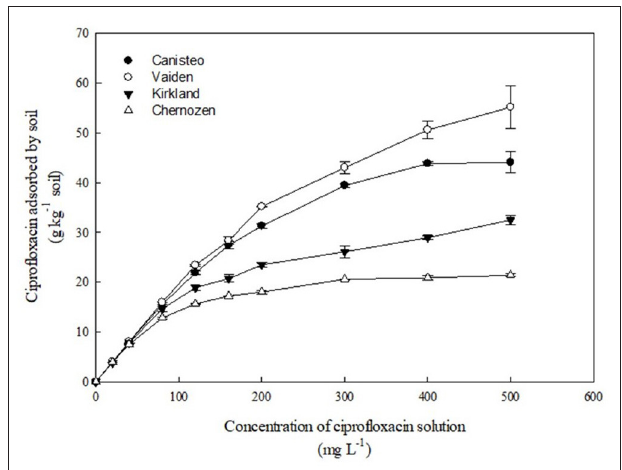
FIGURE 1 | Example sorption isotherms for four (soil 6, 12, 17, and 20) of the 20 soils tested. All 20 soils followed both the Freundlich and Langmuir isothermal shape as determined by correlation ( r )